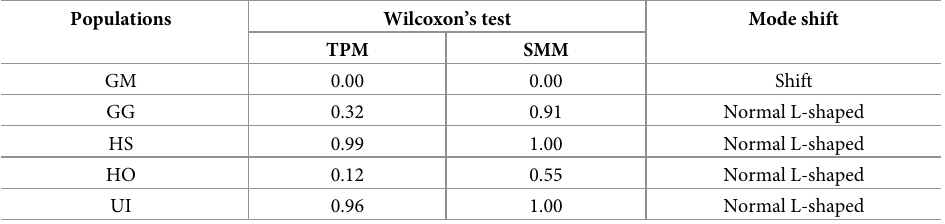
Table 4. The results of Wilcoxon’s signed-rank test and mode shift test implemented in BOTTLENECK software.